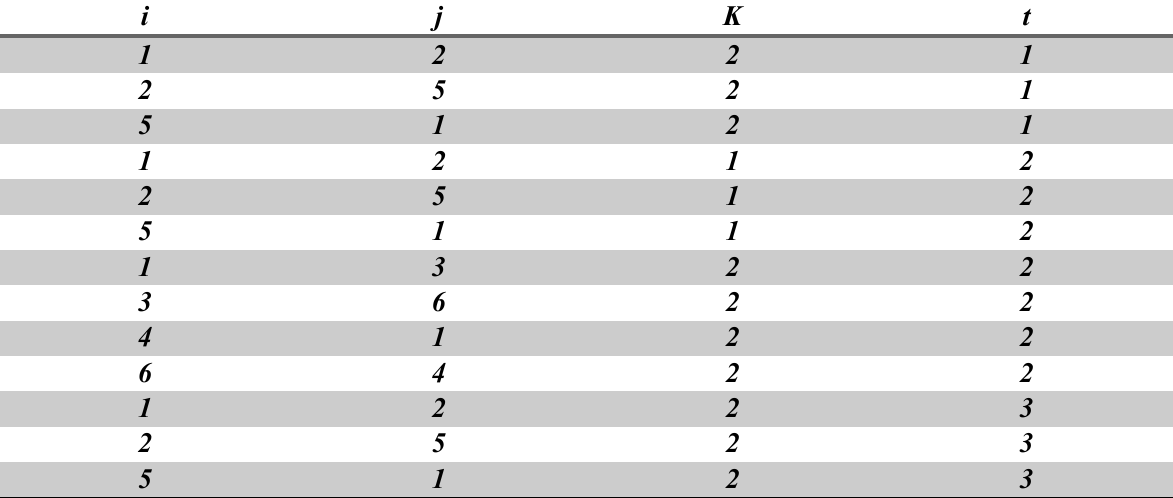
Vehicles used for each node for each period